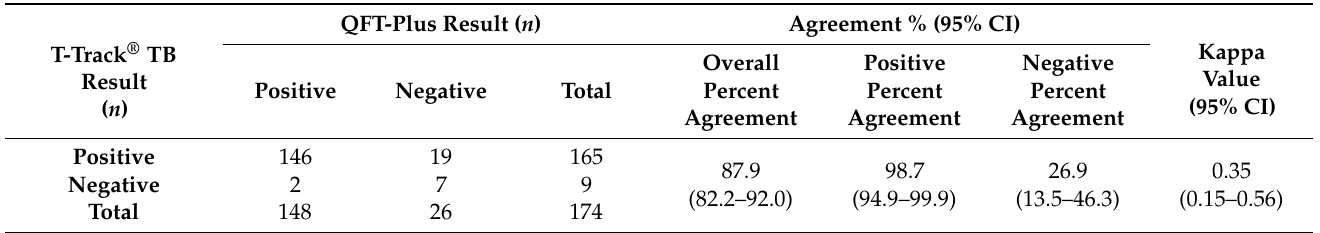
Table 3. Concordance of T-Track ® TB and QFT-Plus assays on samples of active TB patients.